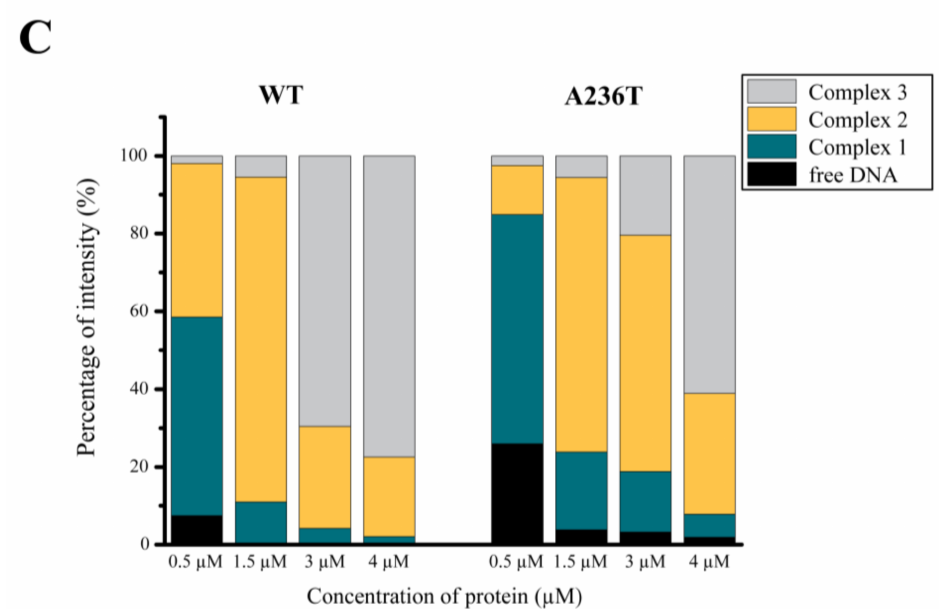
Figure 5. Characterization of the Stl A236T mutant ( A ) Testing the Stl A236T mutant in the Stl switch system. The structural model locates the A236T mutation at the C -terminal domain shown in blue. The HTH motif is colored yellow and the N -terminal domain is colored maroon. The expression of the Stl A236T mutant resulted in blue colonies, verifying that it is defective in DNA binding in vivo; ( B ) Comparative electrophoretic mobility shift assay (EMSA) with Stl WT and Stl A236T . Stl A236T is less prone to complex formation with DNA. Therefore, more of the free DNA is visible at the corresponding bands than that of Stl WT . The comparative EMSA was repeated three times with same results; ( C ) Densitometry results of each of the species exhibiting different electrophoretic mobilities are shown by colored bands. The discrepancy between the wild-type and mutant Stl is quite noticeable, confirming our previous in vivo results. These data suggest that the DNA binding of Stl A236T is compromised in